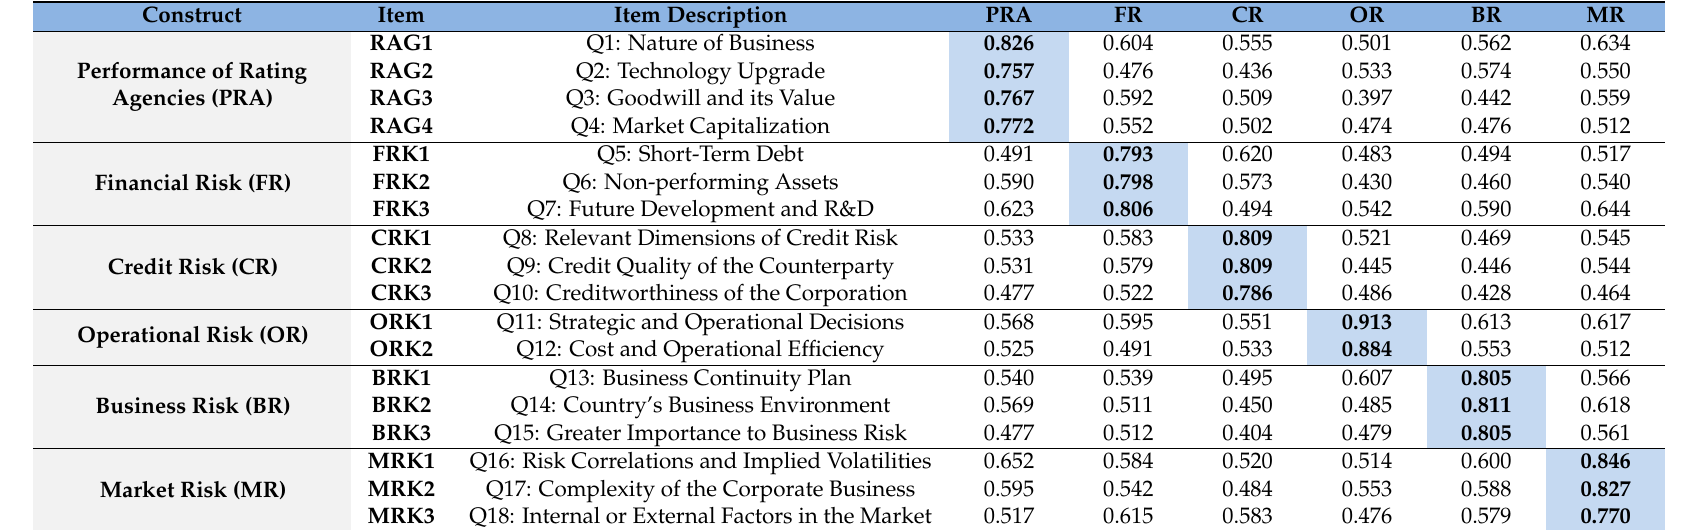
Table 4. Item-to-Construct Correlation vs. Correlations with Other